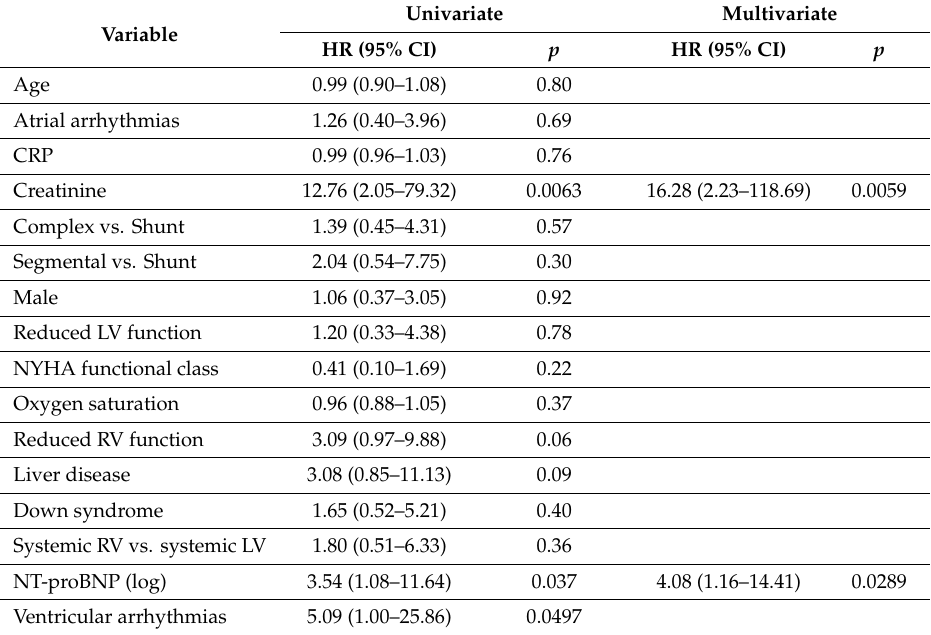
Table 2. Univariate and multivariate analysis of predictors for all-cause mortality.